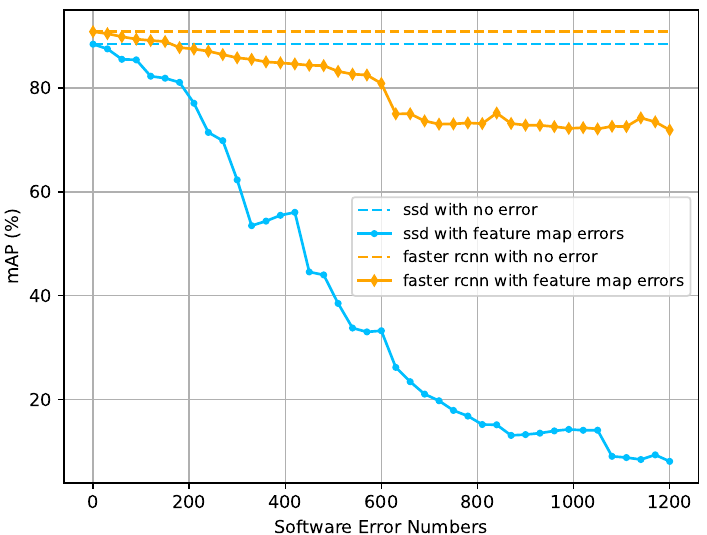
Figure 7. SSD and Faster R-CNN detectors’ performance losses caused by multiple feature map